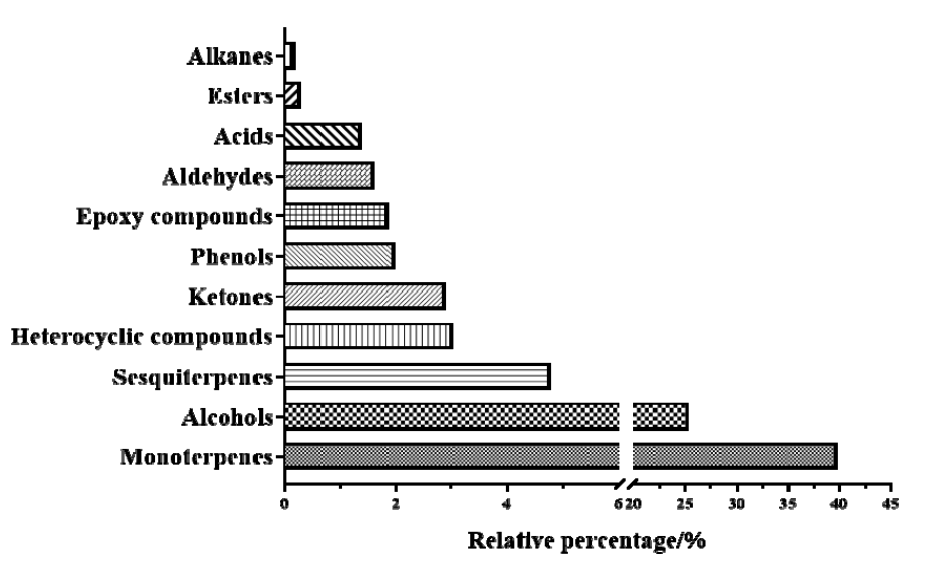
Figure 2. Relative percent contents of various compounds in Oleum Cinnamomi .